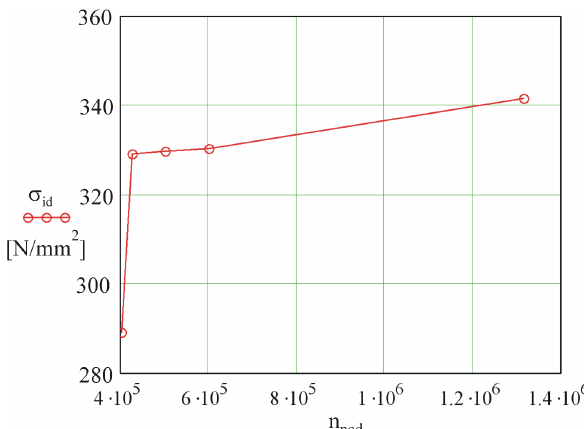
Figure 20: Convergence curve to check the stress σ id in the area where the three edges of the pole piece intersect (see Figure 19, fillet radius R=0.5 mm).